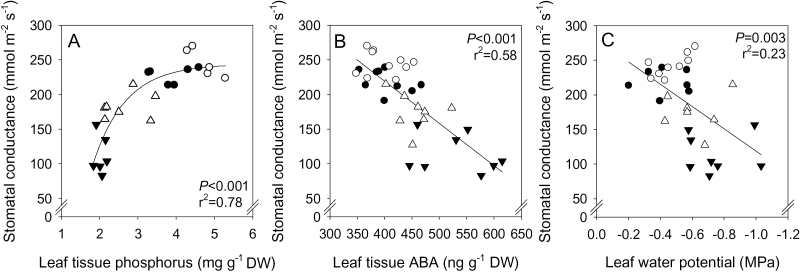
Relationship between stomatal conductance and leaf tissue phosphorus concentration (A), leaf water potential (B), and leaf tissue ABA concentration (C) of lime- (filled triangle), lime+P fertilizer- (open triangle), control (filled circle), and control+P fertilizer- (open circle) treated Pisum sativum. Data points represent individual plants with hyperbolic decay (A) or linear (B, C) regression lines fitted, and P values and r
2 reported.